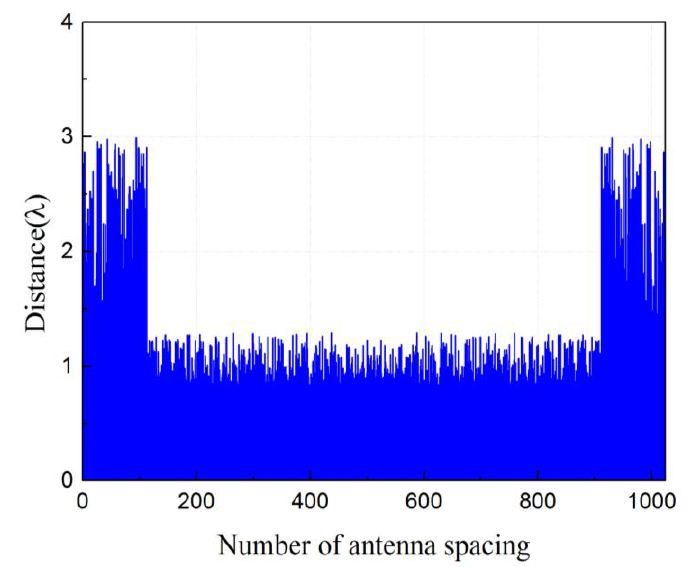
Figure 3. Optimized antenna spacing distribution of an array with 1024 antennas.